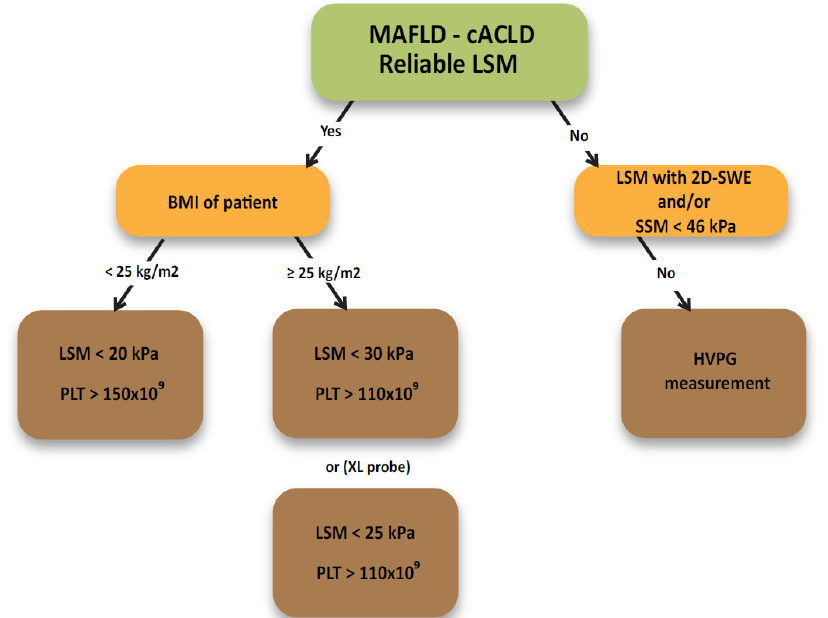
Figure 4. Elastographic evaluation of VNT presence. Sequential SSM-VNT evaluation is possible after every LSM-VNT evaluation protocol. MAFLD—metabolic dysfunction-associated fatty liver disease. cACLD—compensated advanced chronic liver disease. LSM—liver stiffness measurement. SSM—spleen stiffness measurement. BMI—body mass index. PLT—platelets count (counts per microliter of blood) . HVPG—hepatic venous pressure gradient .